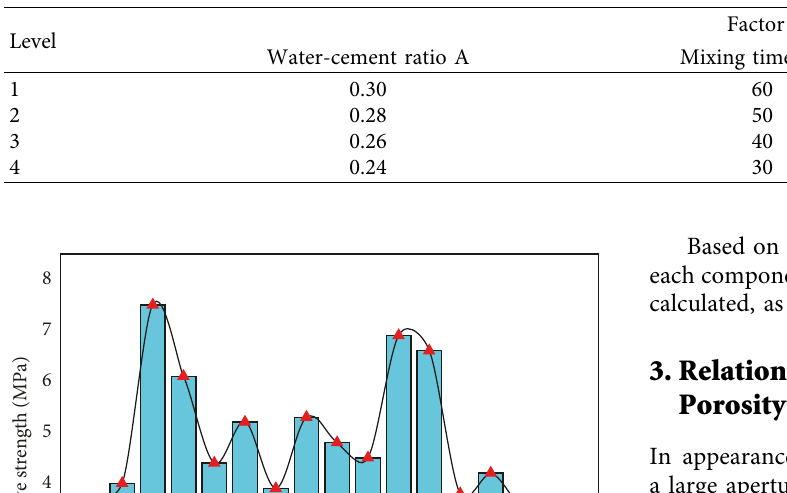
Table 4: Factor level table of orthogonal test.